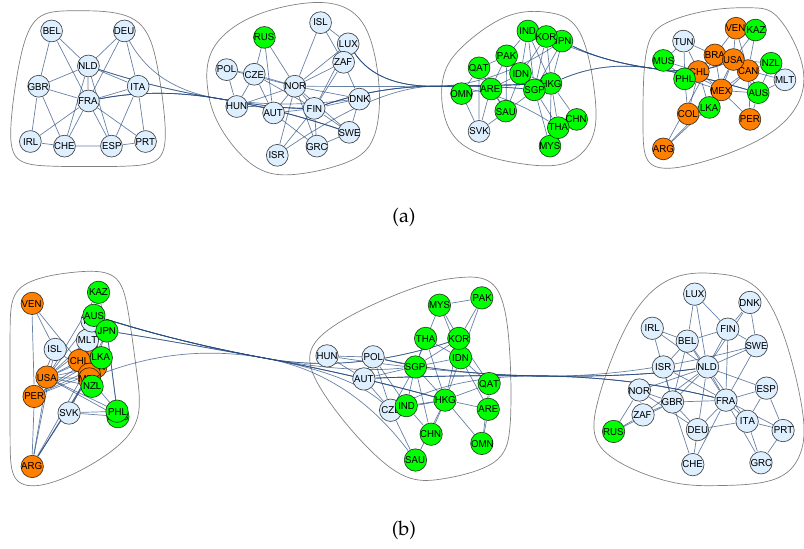
Figure 4. Planar maximally filtered graph (PMFG) for the stock markets obtained using lagged correlations during ( a ) the economically calm period and ( b ) crisis period. The countries are denoted by their three-letter symbols and are color-coded according to their geographical locations: green for Asia, light blue for Europe and orange for the Americas. During the calm period, we observe four large clusters, while in the crisis period the number of communities changes to three, as the two European clusters